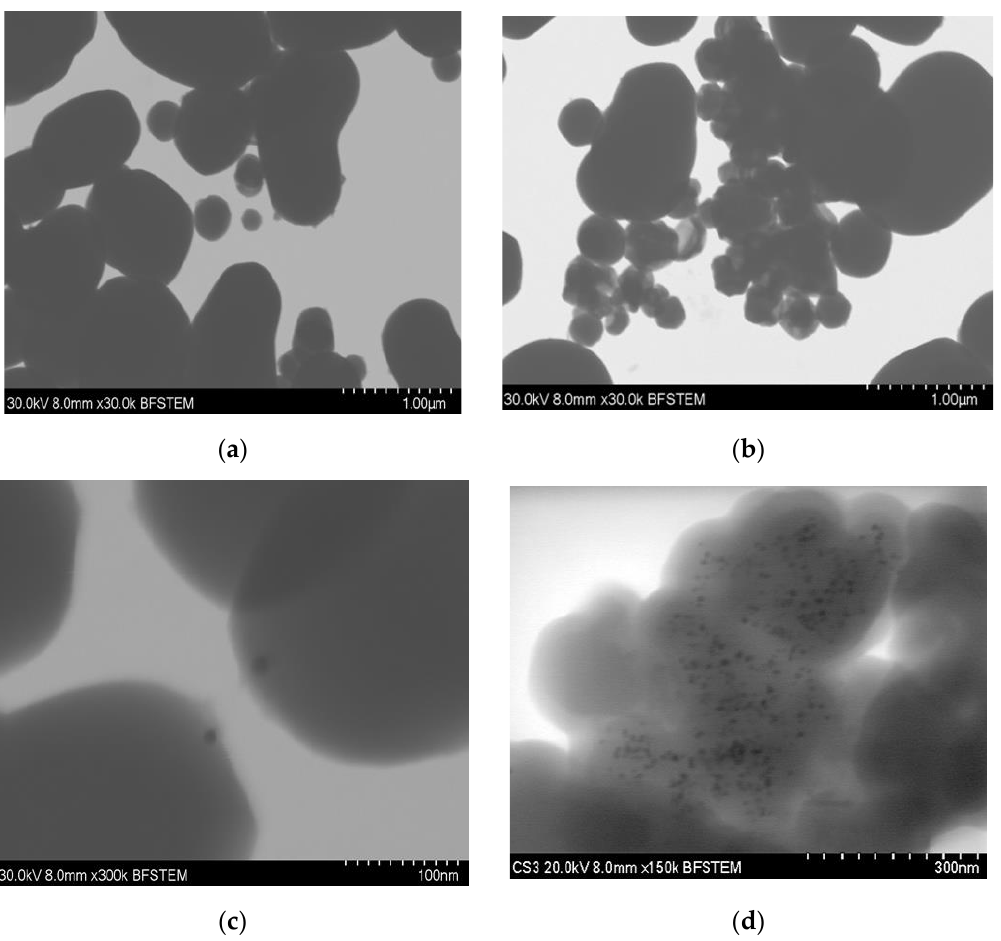
Figure 2. STEM micrographs of silica–gold nanoparticles ( a ) blank S1, ( b ) blank S2, ( c ) Mullein S1, ( d ) Mullein S2.